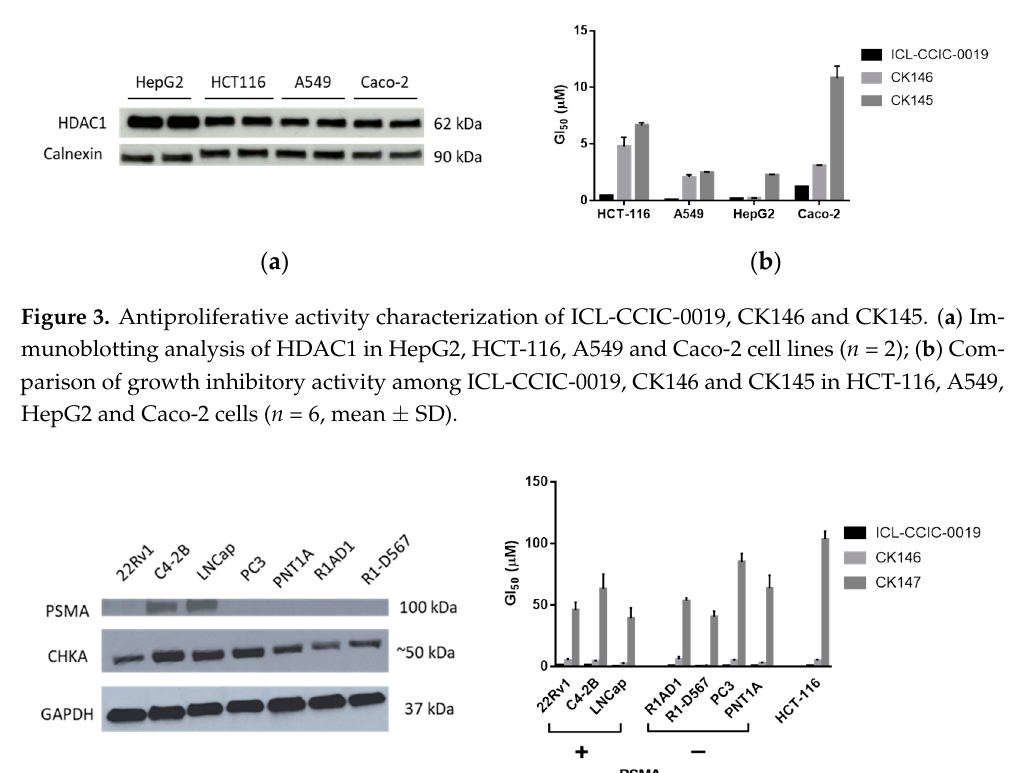
Figure 3. Antiproliferative activity characterization of ICL-CCIC-0019, CK146 and CK145. ( a ) Im- munoblotting analysis of HDAC1 in HepG2, HCT-116, A549 and Caco-2 cell lines ( n = 2); ( b ) Com- parison of growth inhibitory activity among ICL-CCIC-0019, CK146 and CK145 in HCT-116, A549, HepG2 and Caco-2 cells ( n = 6, mean ± SD).